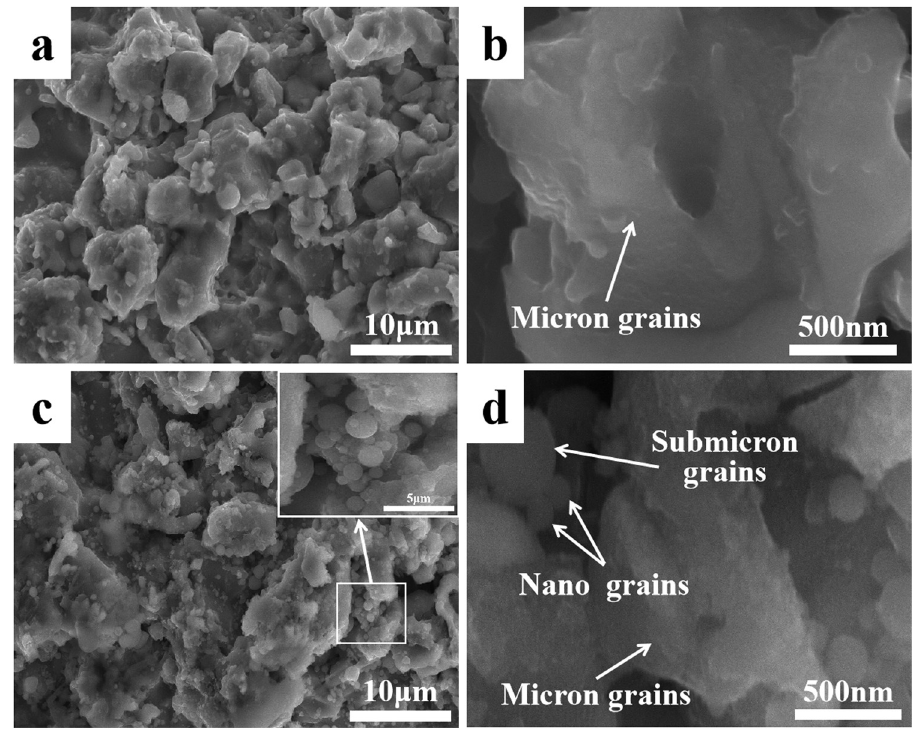
Figure 4: SEM images of Cr 3 C 2 – NiCr coatings top surface: ( a ) CC, ( b ) higher magni fi cation view of CC, ( c ) MC, and ( d ) higher magni fi cation view of MC.